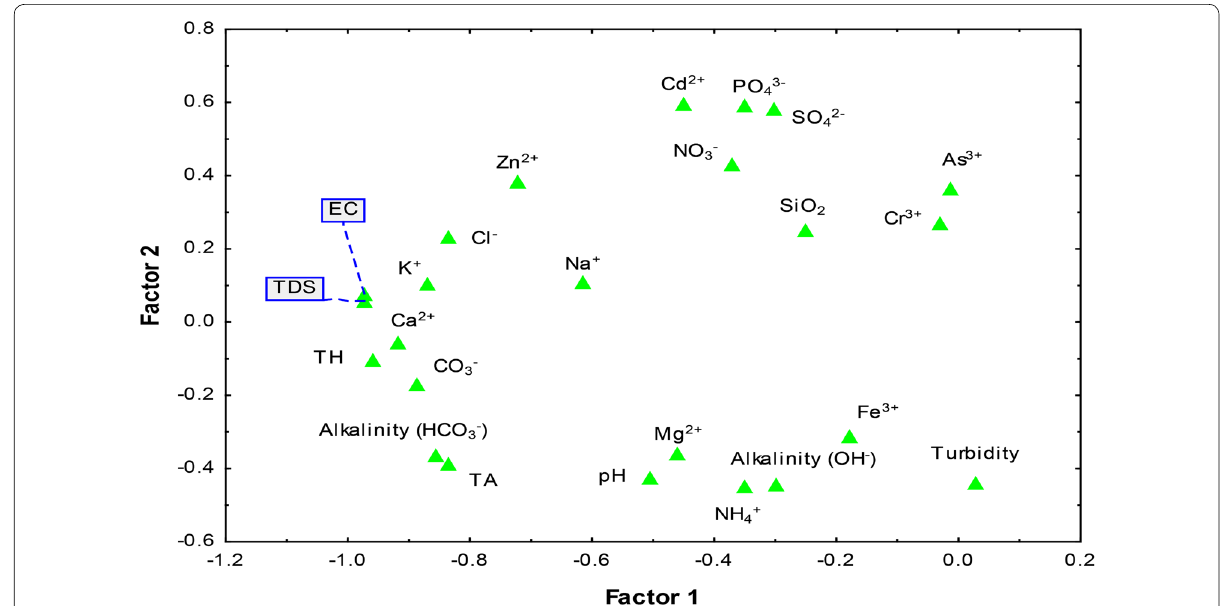
Fig. 8 Factor analysis diagram. Factor loadings: Factor 1 versus Factor 2. Loading: unrotated, extraction: principal components